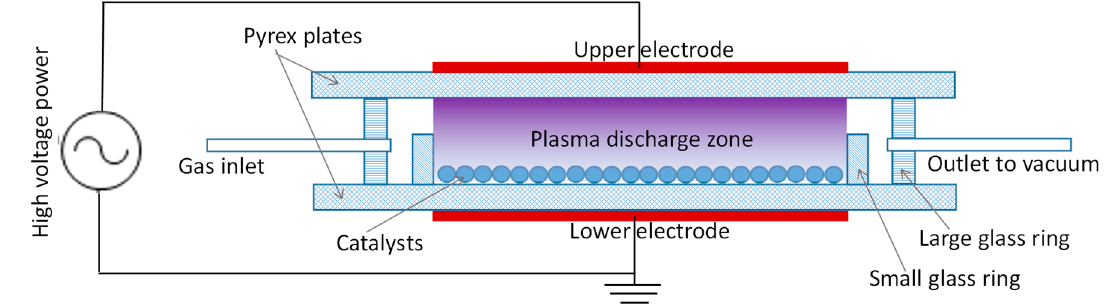
Figure 6. Schematic of NTP fabrication apparatus.